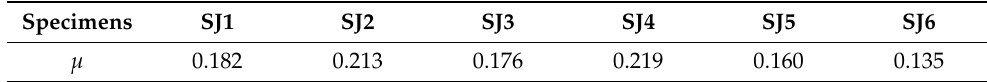
Table 4. The average sliding friction coefficient of the friction energy dissipation composite chord specimens.